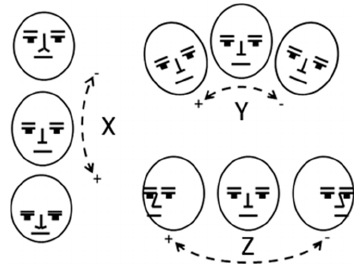
Figure 3. Head’s principle axes of motion [16], where X denotes pitch (nodding), Y denotes roll and Z denotes yaw (shaking).